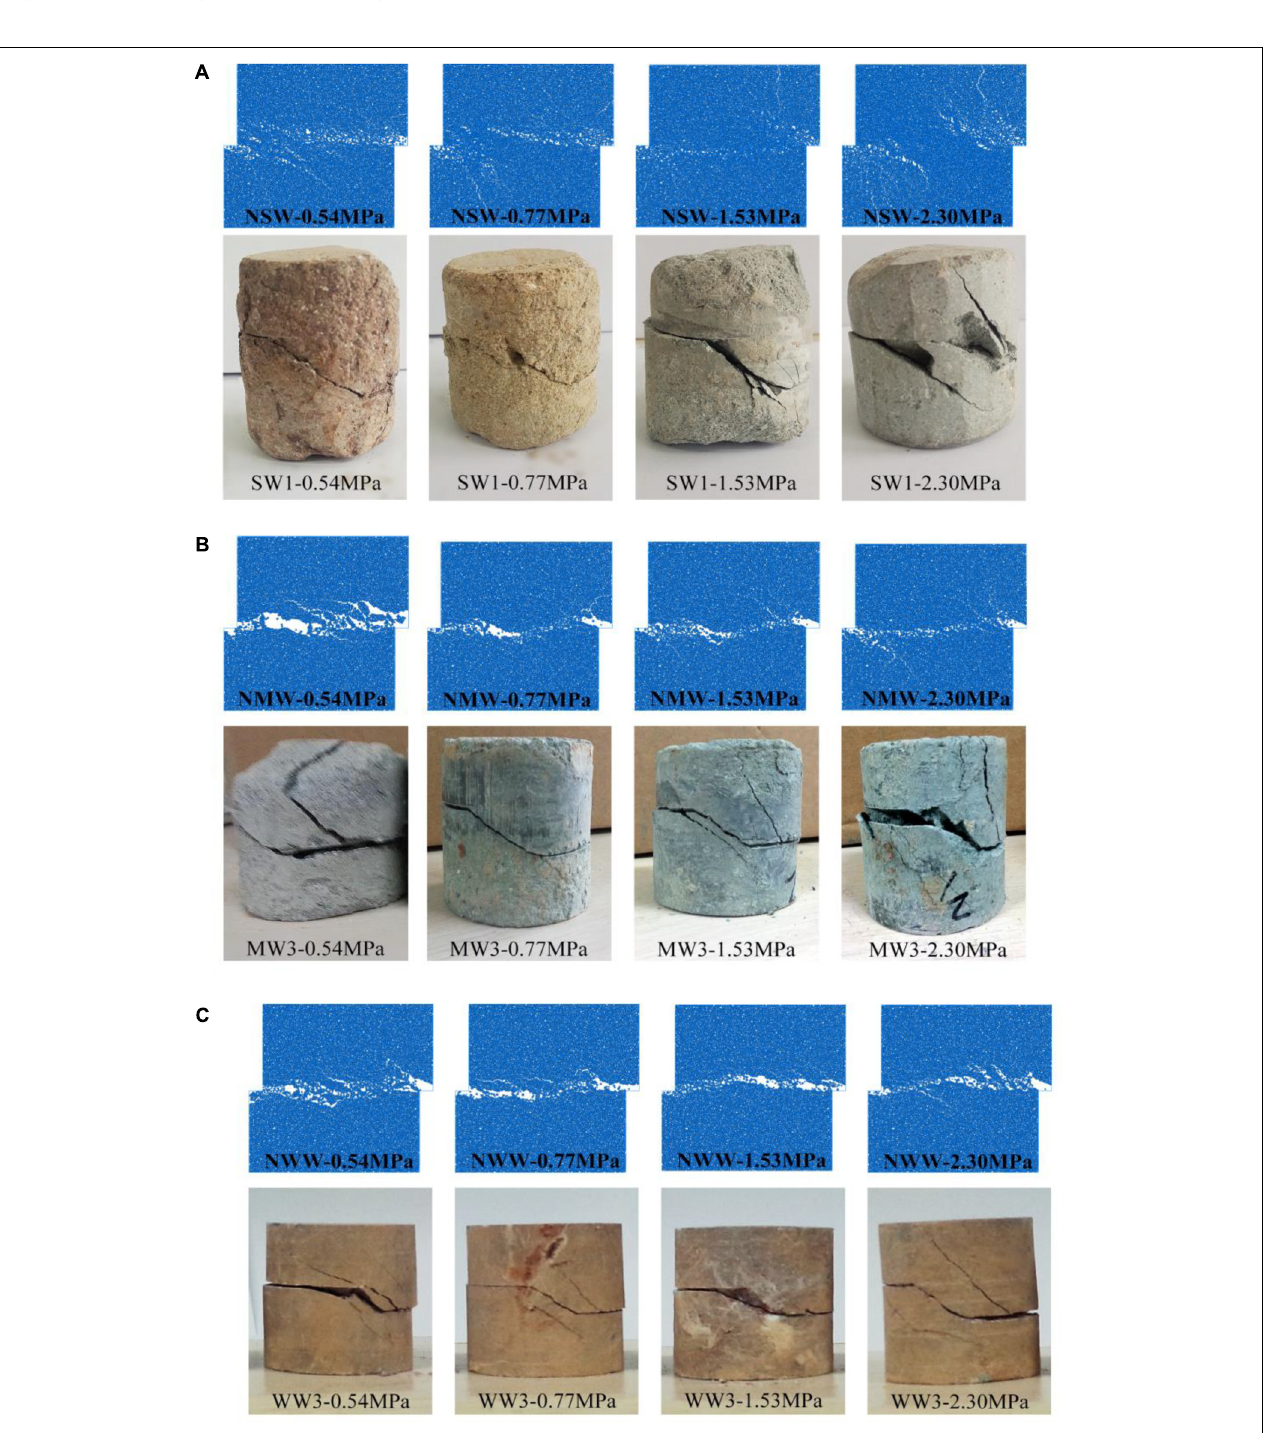
FIGURE 10 | Crack morphology of the different weathered samples after experiencing shear process at different normal stresses. (A) Strongly weathered samples. (B) Moderately weathered samples. (C) Weakly weathered samples.